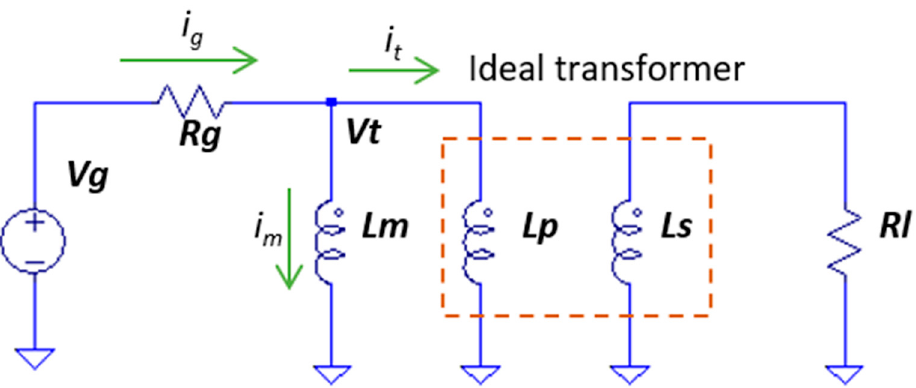
Figure 1. The real transformer is modelled with the magnetization inductance, Lm , followed by an ideal transformer, Lp / Ls . The transformer is powered by the generator, Vg , through the resistor, Rg , and it is loaded by Rl .